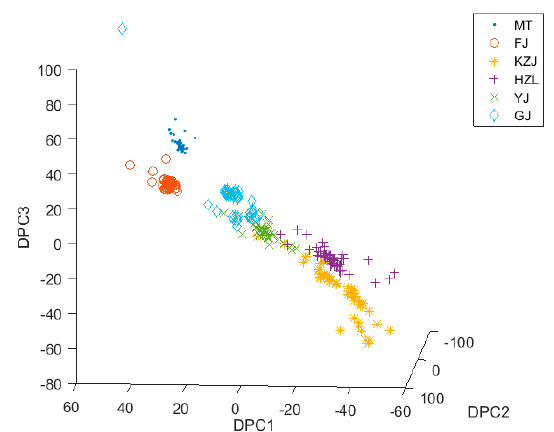
Figure 6. Three-dimensional distribution of data after discriminant principal component analysis (DPCA).